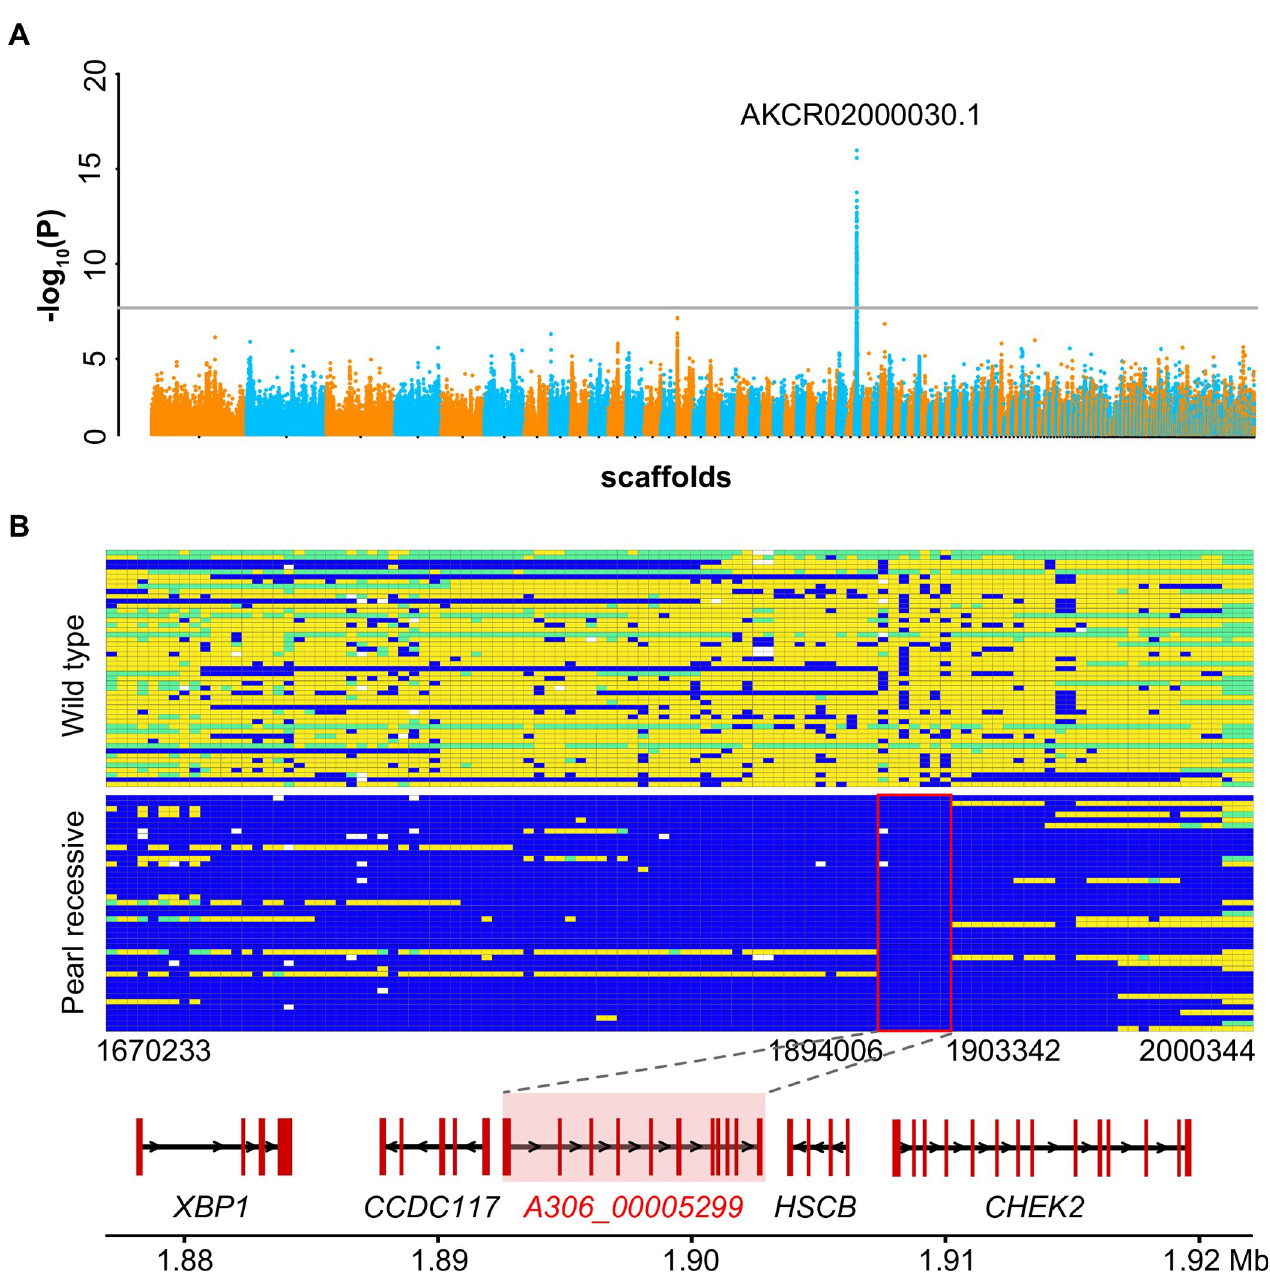
Fig 2. Genomic mapping of the Tr locus. (A) The Manhattan plot of the GWAS analysis for the Tr locus. The gray line indicates the Bonferroni-corrected critical value ( P = 2.01 × 10 − 8 ). The scaffold with the strongest association signal is marked. (B) The genotypes of 92 pigeons across the mapped region associated with the pearl eye. Each row represents one individual, and each column represents an SNP/indel. Blue indicates homozygosity for the major allele in pearl- eyed pigeons, yellow indicates homozygosity for the minor allele in pearl-eyed pigeons, green indicates heterozygosity, and white indicates missing data. A shared haplotype (scaffold 30: 1,894,006–1,903,342) was identified. Genes located in and around the shared region are labeled. avian skin. On the contrary, SLC2A11B was highly expressed in iris, exhibiting an 8.88-fold increase ( P < 0.001) relative to that of the skin tissue (Fig 4A). Using the expression in skin as a baseline, higher level of expression of SLC2A11B was also observed in several other tissues,